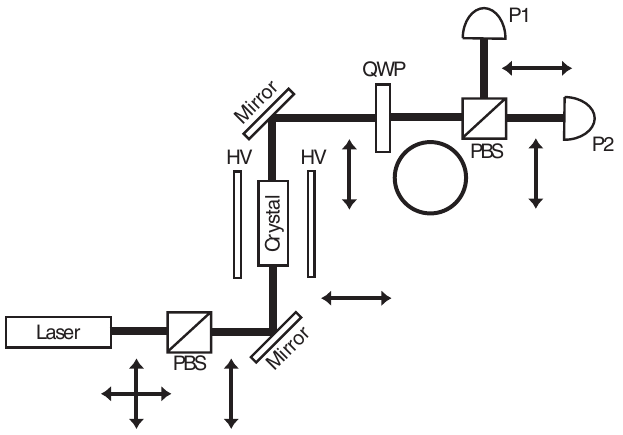
FIG. 10. Drawing of the optical setup used in the electro- optical measurement. PBS is a polarizing beam splitter cube, QWP is a quarter-wave-plate, high voltage electrodes are in- and P are photodiodes. The light dicated by HV, and P 1 2 polarization is indicated with arrows and a circle.